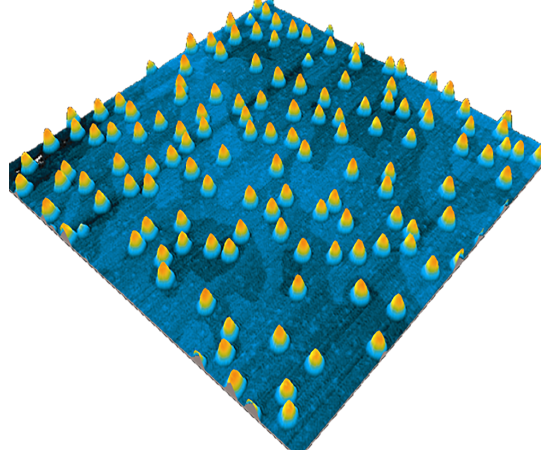
Figure 3. 1 × 1 µ m 2 atomic force microscopy (AFM) image of InAs quantum dots grown on a GaAs surface by Stranski-Krastanov growth mode. Atomic steps on the GaAs surface can be seen in between the QDs. Adopted from Ref.